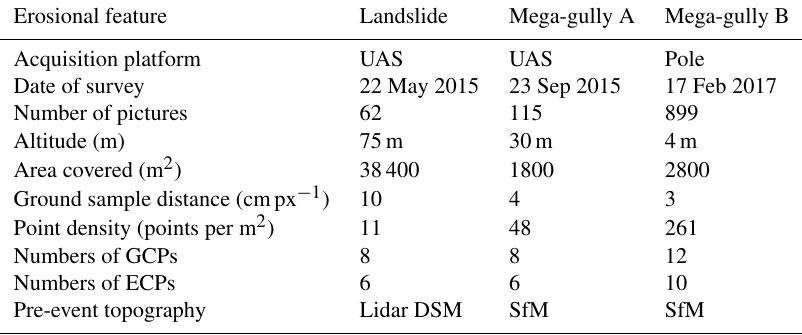
Table 1. Structure-from-motion survey description and data acquisition. GCPs and ECPs denote ground control points and error control points, respectively. UAS denotes unmanned aerial